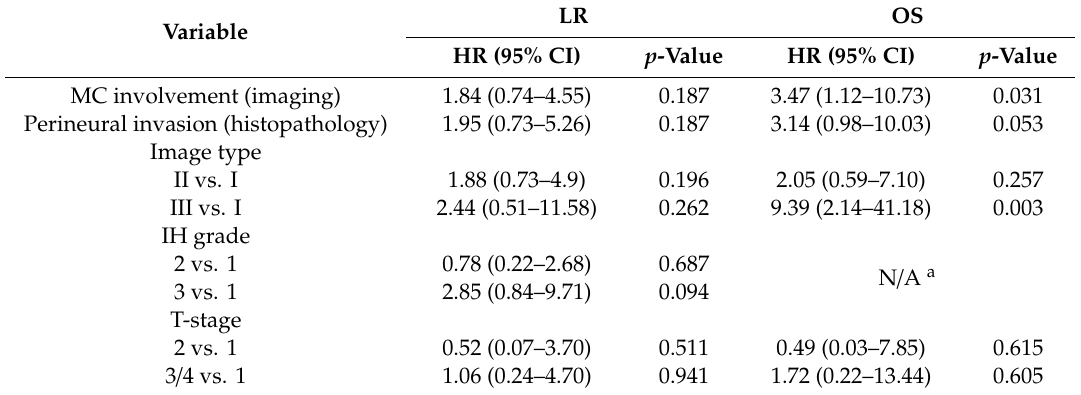
Table 3. Univariate analysis for predicting locoregional recurrence (LR) and overall survival (OS).